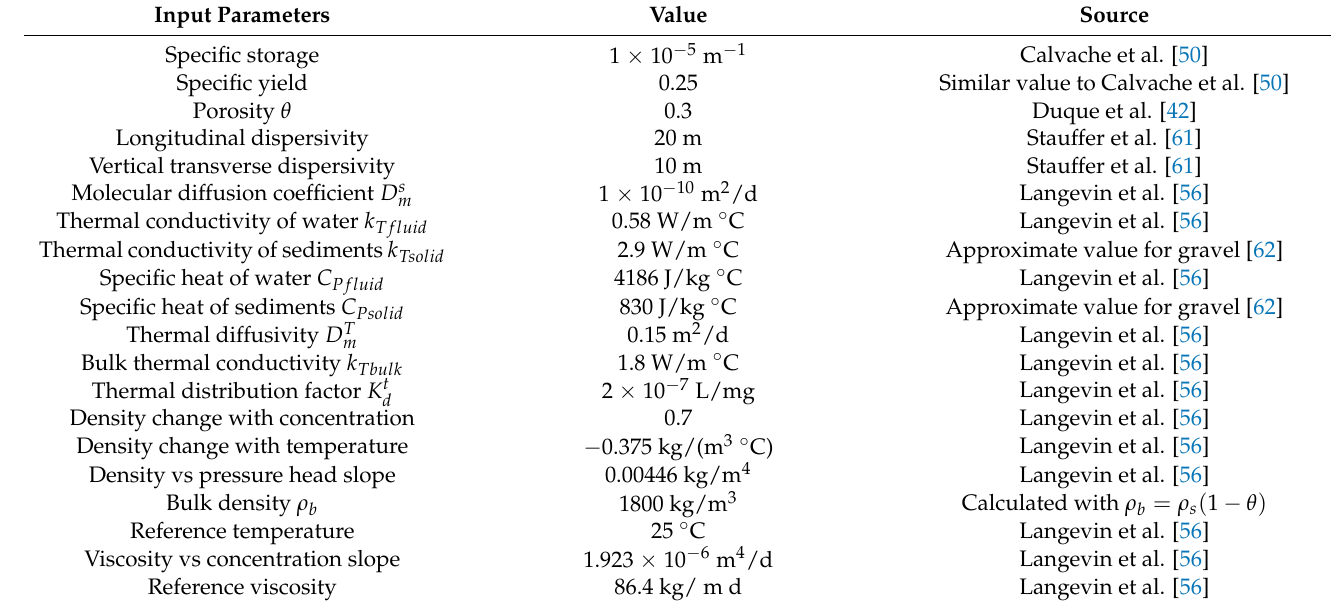
Table 2. Input values of the parameters for the